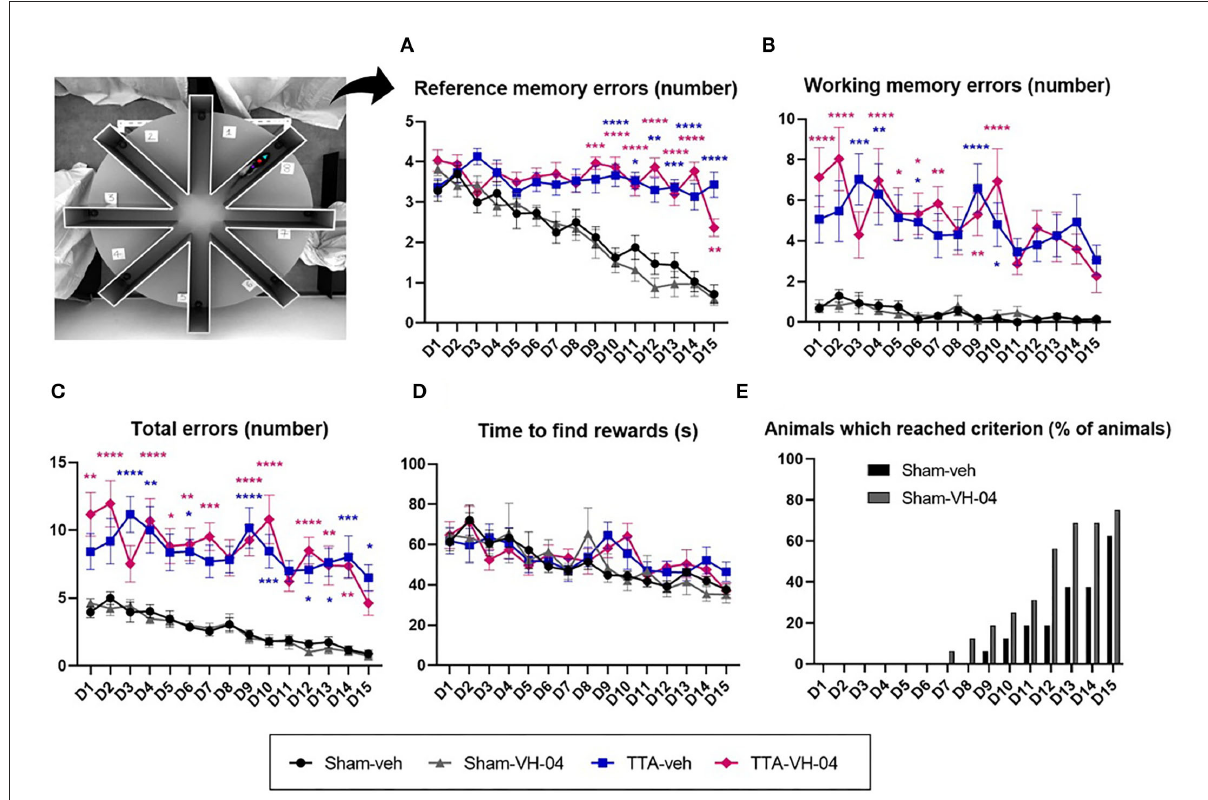
FIGURE6 Effect of Vertigoheel on the spatial working and reference memory assessed by the eight radial arms maze. (A) Number of reference memory errors: long-term memory. (B) Number of working memory errors: short-term memory. (C) Total number of errors. (D) Mean trial completion time (s). Data represent mean ± SEM. Three-way ANOVA applies to all graphs except (E) . Significant differences between Sham-VH-04 and TTA-VH-04, and Sham-veh and TTA-veh are indicated by purple and blue stars, respectively. * p < 0.05; ** p < 0.01; *** p < 0.001; **** p < 0.0001. Sham-veh and Sham VH-04, n = 16; TTA-veh and TTA-VH-04, n =